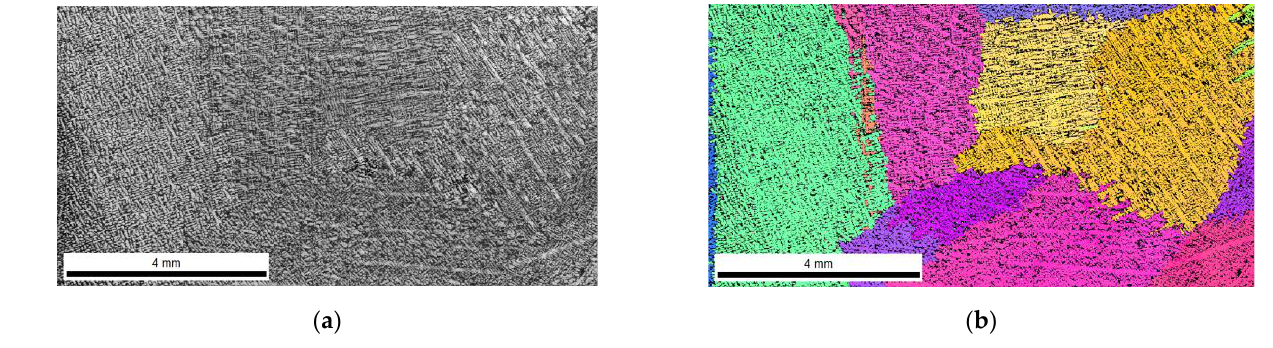
Figure 7. Structure of chromium cast iron in a 30 mm thick plate. ( a ) light microscope; ( b ) EBSD.